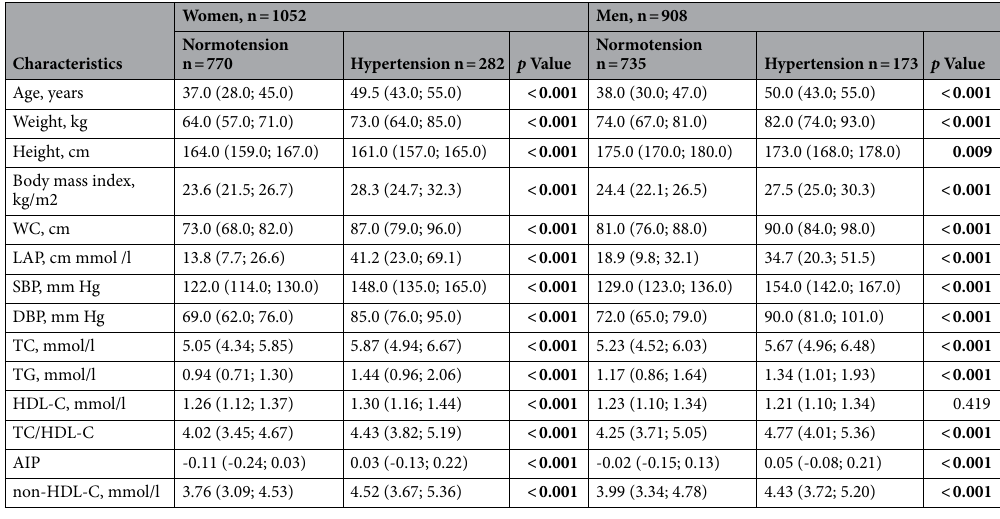
Table 1. Baseline characteristics of participants with and without hypertension. Bold values indicate p < 0.05 Data are presented as the median and interquartile range (25th and 75th percentile). Mann–Whitney test was used to estimate differences between the groups. WC, waist circumference; LAP, lipid accumulation product; SBP, systolic blood pressure; DBP, diastolic blood pressure; TC, total cholesterol; TG, triglycerides; HDL-C, high-density lipoprotein cholesterol; AIP, atherogenic index of